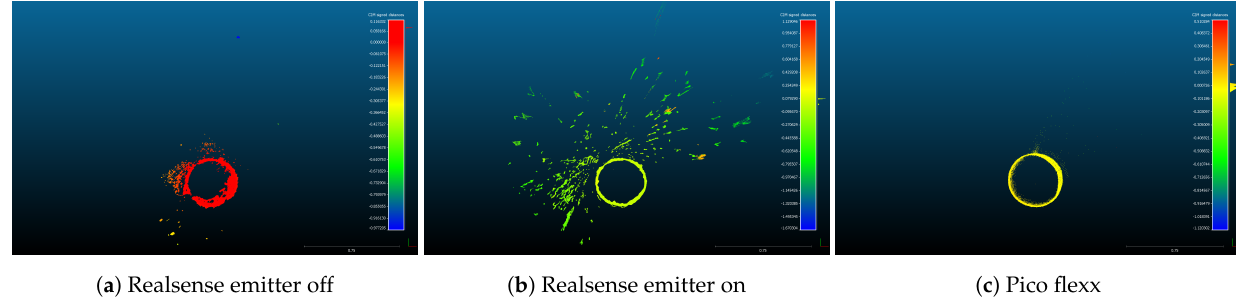
Figure 5. Cloud-to-mesh distances from the depth sensor to the 3D model (not shown). Screenshots from CloudCompare [78]. Please note that the color scale vary between the